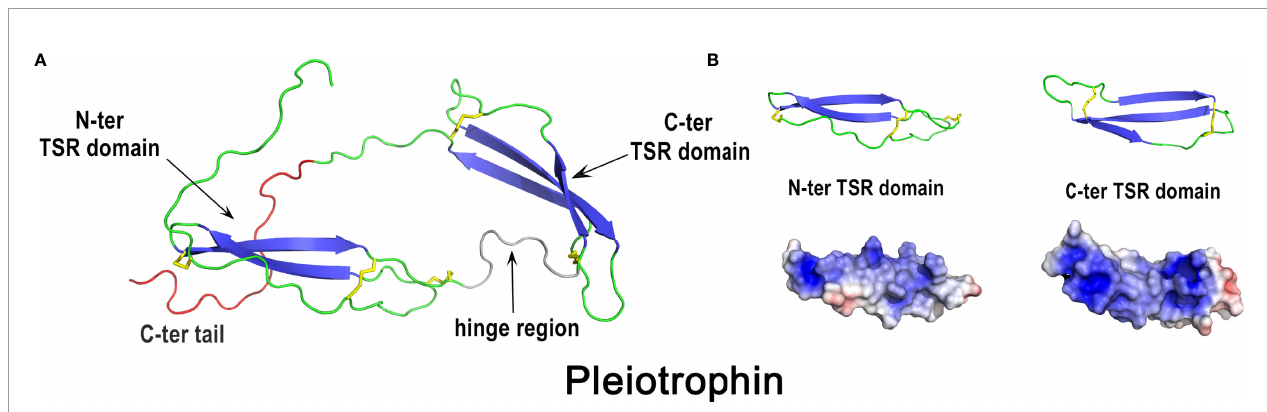
FIGURE 11 | 3D structure of pleiotrophin. The left panel (A) corresponds to the cartoon representation of chicken pleiotrophin 3D structure while the right panel (B) illustrates the color-coded electrostatic potential molecular surface of N-ter and C-ter domains. Color scheme ranges from red (negatively charged regions) to deep blue (positively charged regions). Pleiotrophin has two thrombospondin type-1 repeat domains (TSR), one with a two-stranded b -sheet (N-ter domain) and the second with a three-stranded b -sheet (C-ter domain) linked by a fl exible hinge region. Both TSR domains are fl anked by unstructured termini. The structure of chicken pleiotrophin was predicted by comparative modeling using SwissModel server (swissmodel.expasy.org) and human pleiotrophin (PDB code 2N6F) as a template. The fi gure was prepared using Pymol software (48) and APBS (Adaptive Poisson-Boltzmann Solver) plugin (49) for electrostatic